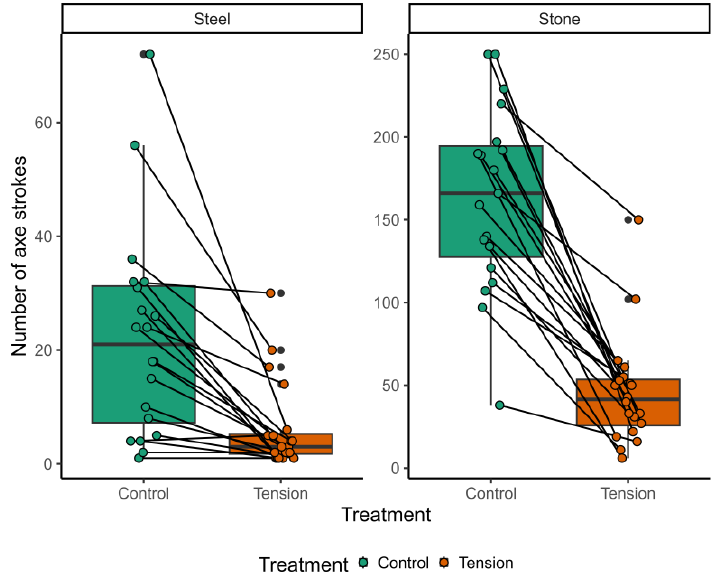
Figure 2. Number of axe blows required to fell 3.5–5.6 cm diameter Q. hemisphaerica trees by axe type (stone or steel) and whether or not the stems were pre-tensioned by bending. The lines connect individual choppers. Note the different y-axis scales.